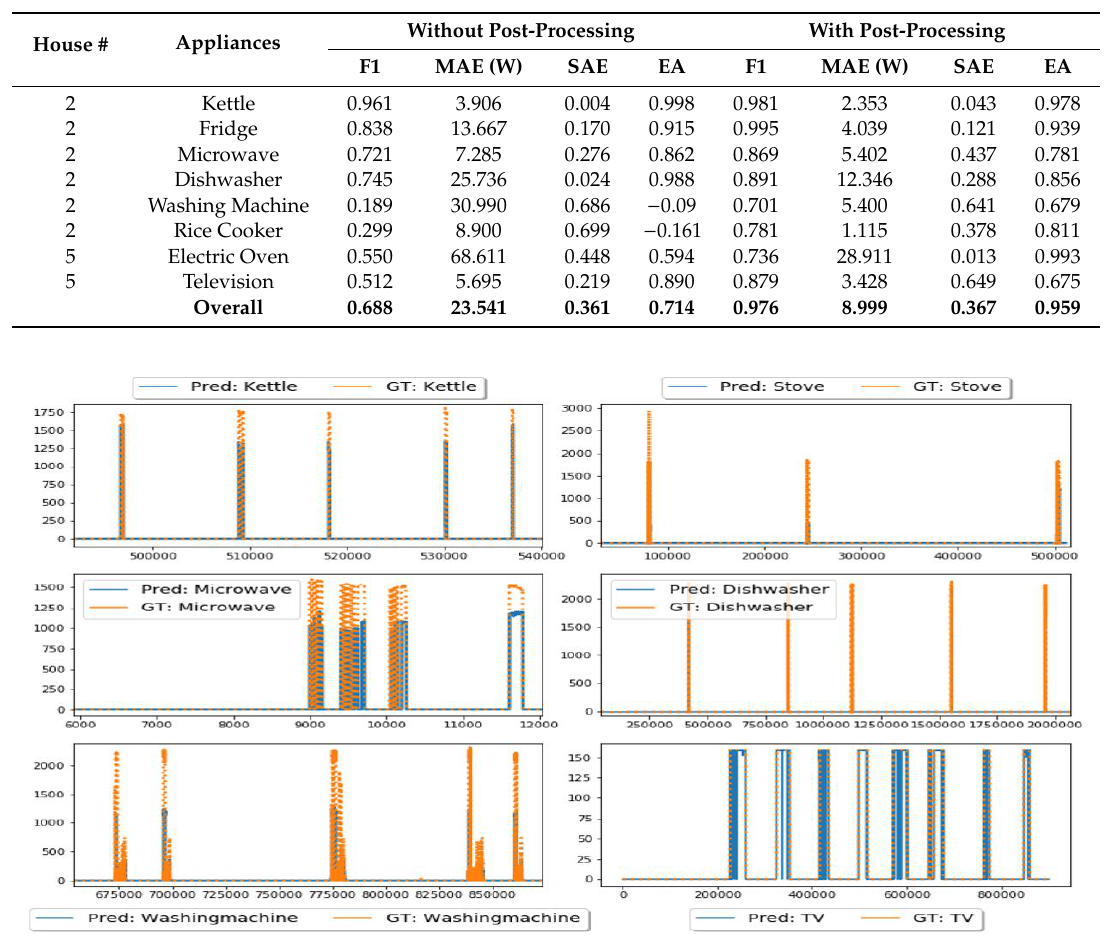
Figure 8. Seen Scenario: Disaggregation results of all target appliances from the ECO dataset Although our algorithm was able to classify all target appliance activations, the presence of irrelevant activations in Figure 6 (left) indicates that the deep LSTM model learned some features of non-target appliances during training. This can happen due to the similar looking activation profiles of type-1 and type-2 appliances. This e ff ect was eliminated with the use of the post-processing technique whose advantage can easily be realized with the results shown in Tables 2 and 3 for a seen